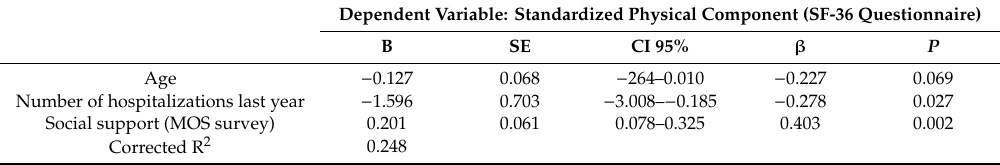
Table 3. Regression model for perceived physical quality of life.